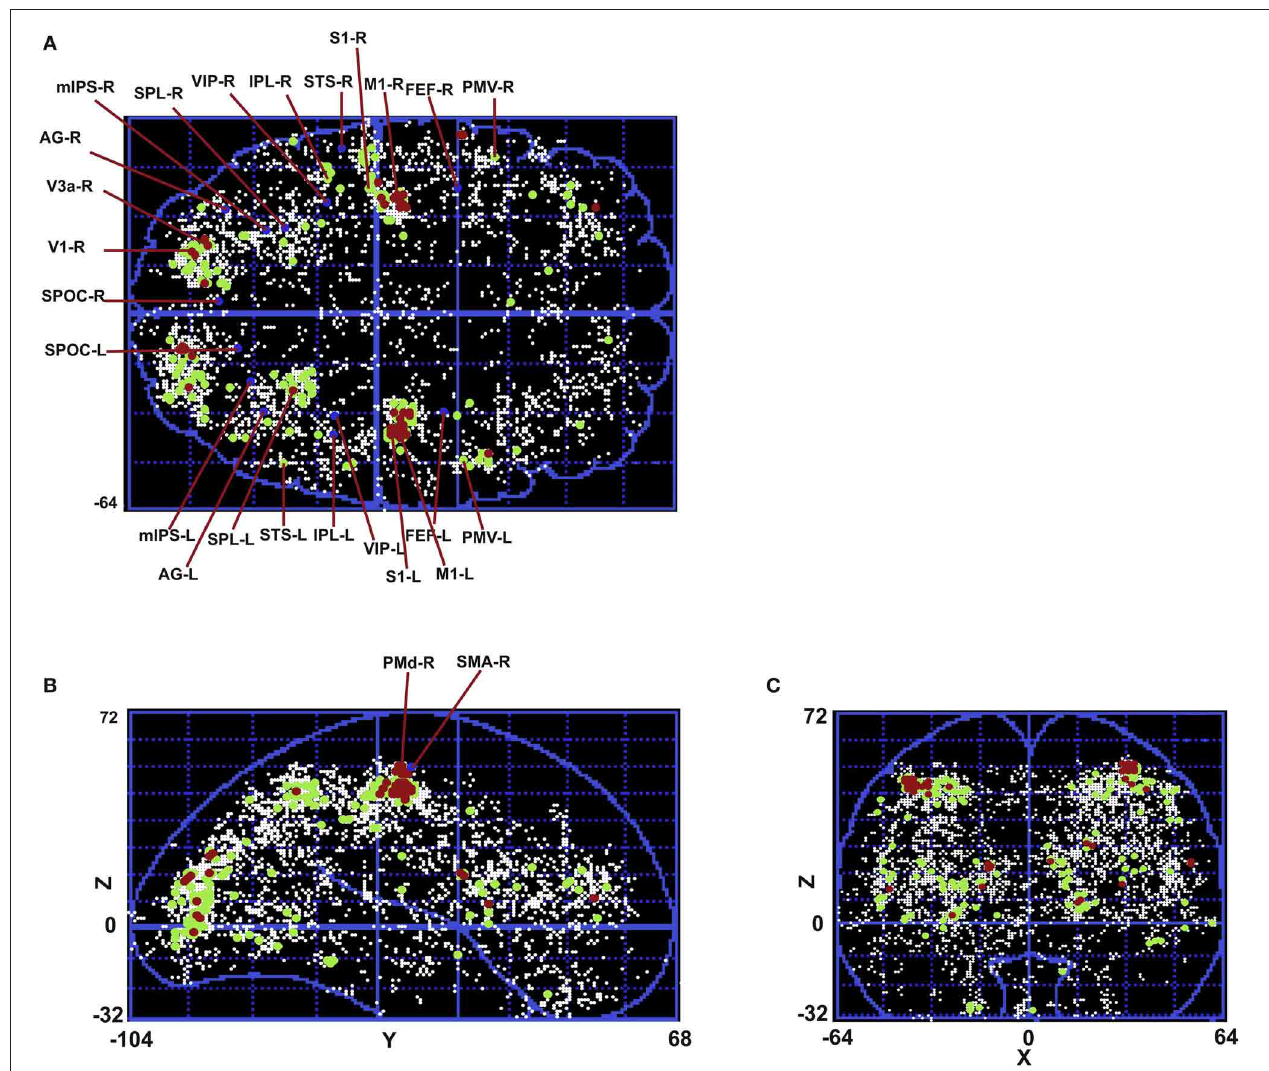
FIGURE 8 | Mesh analysis method is used to find normalized spatial density. Areas with spatial density from 10 to 20%, 20 to 30%, and greater than 30% are shown in white, green, and red,